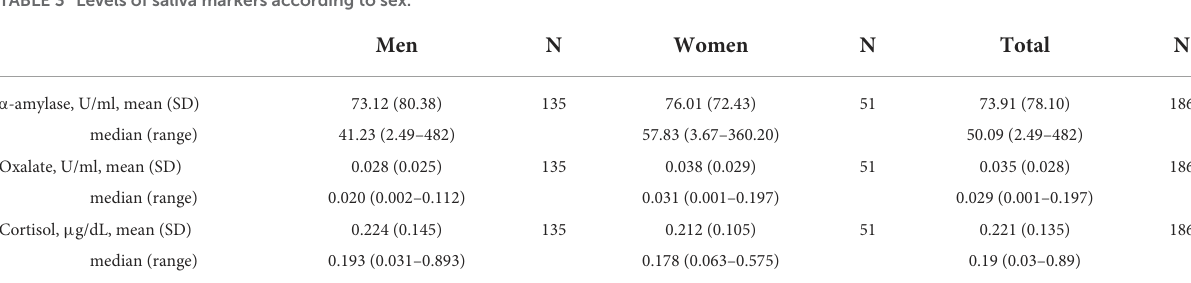
TABLE 3 Levels of saliva markers according to